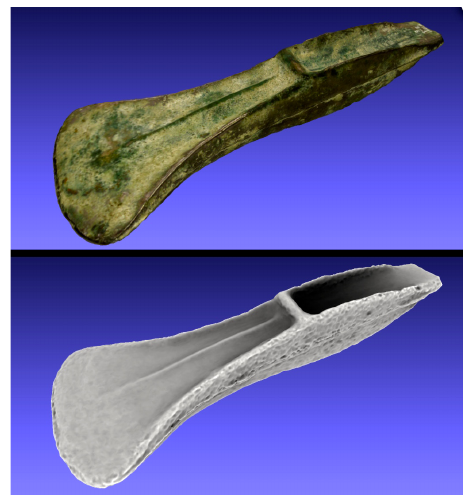
Fig. 5: A 3D model of a Bronze Age pal- stave, shown both with a photographic texture and with an ‘ambient occlusion’ surface (for an online version visible in most browsers on a desktop/laptop, see